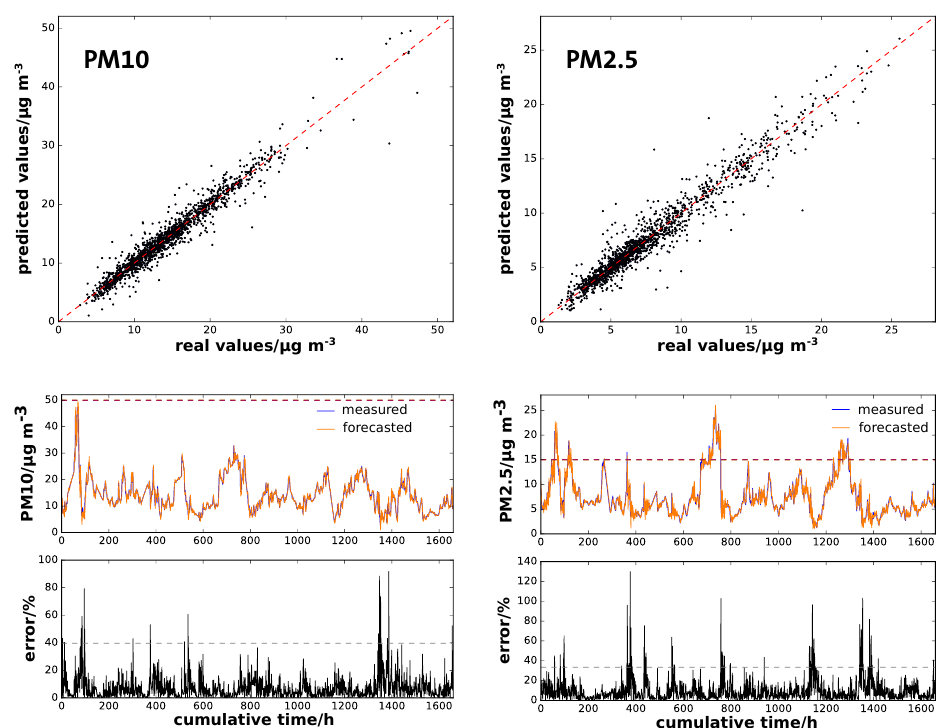
Figure 3. Dispersion, concentration, and errors over time dependencies for the third test iteration of forecasting without seasonality decomposition with weekly seasonality decomposition. Dispersion plots: R 2 = 0.917 for PM10 and R 2 = 0.909 PM2.5.